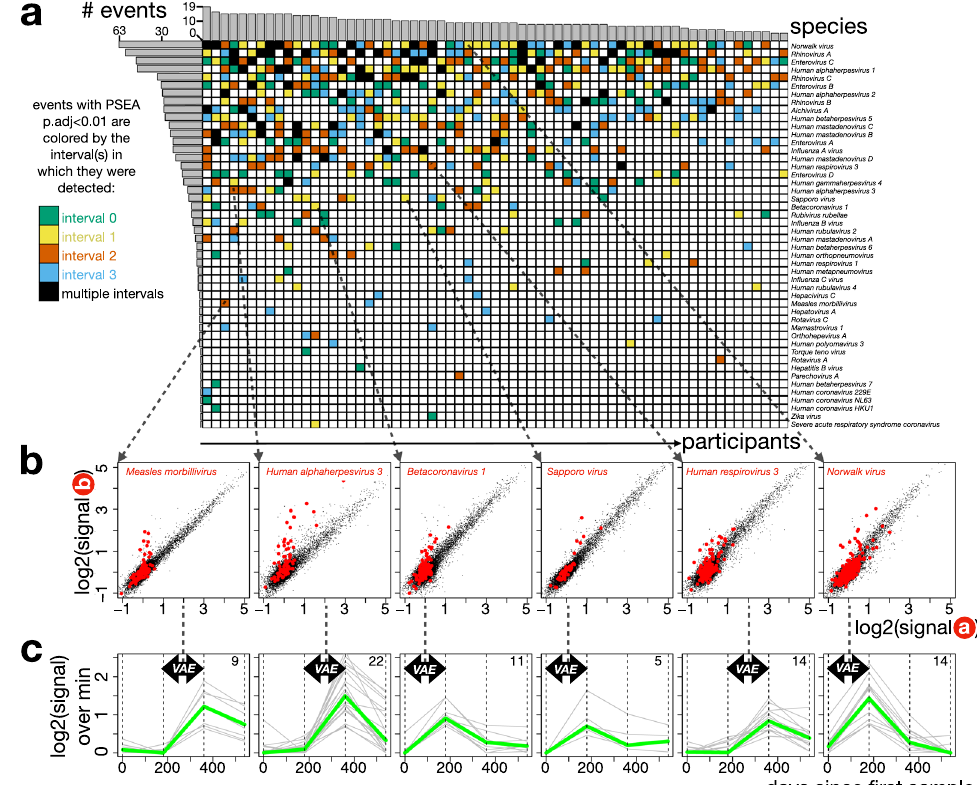
Fig. 2 | Detection of events across the virome in a cohort spanning ~100 total person-years.a For all 65 participants(columns) in the ACS cohortfor whom data on 4 × 6-monthly timepoints were available, PSEA analysis was applied to each of the 3 pairs of consecutive timepoints across all 80 viral species represented in the HV2T library. Shown in rows are the 48 species for which ≥ 1 signi fi cant viral event (adjusted p value <0.01) was observed across the cohort. Signi fi cant events are colored by the interval(s) in which they were detected. b Example peptide-level scatterplots for 6 of the (659 total) viral events identi fi ed in ( a ). Each plot shows signals from the 15,000 HV2T peptides (1 dot per peptide) at the 2 timepoints